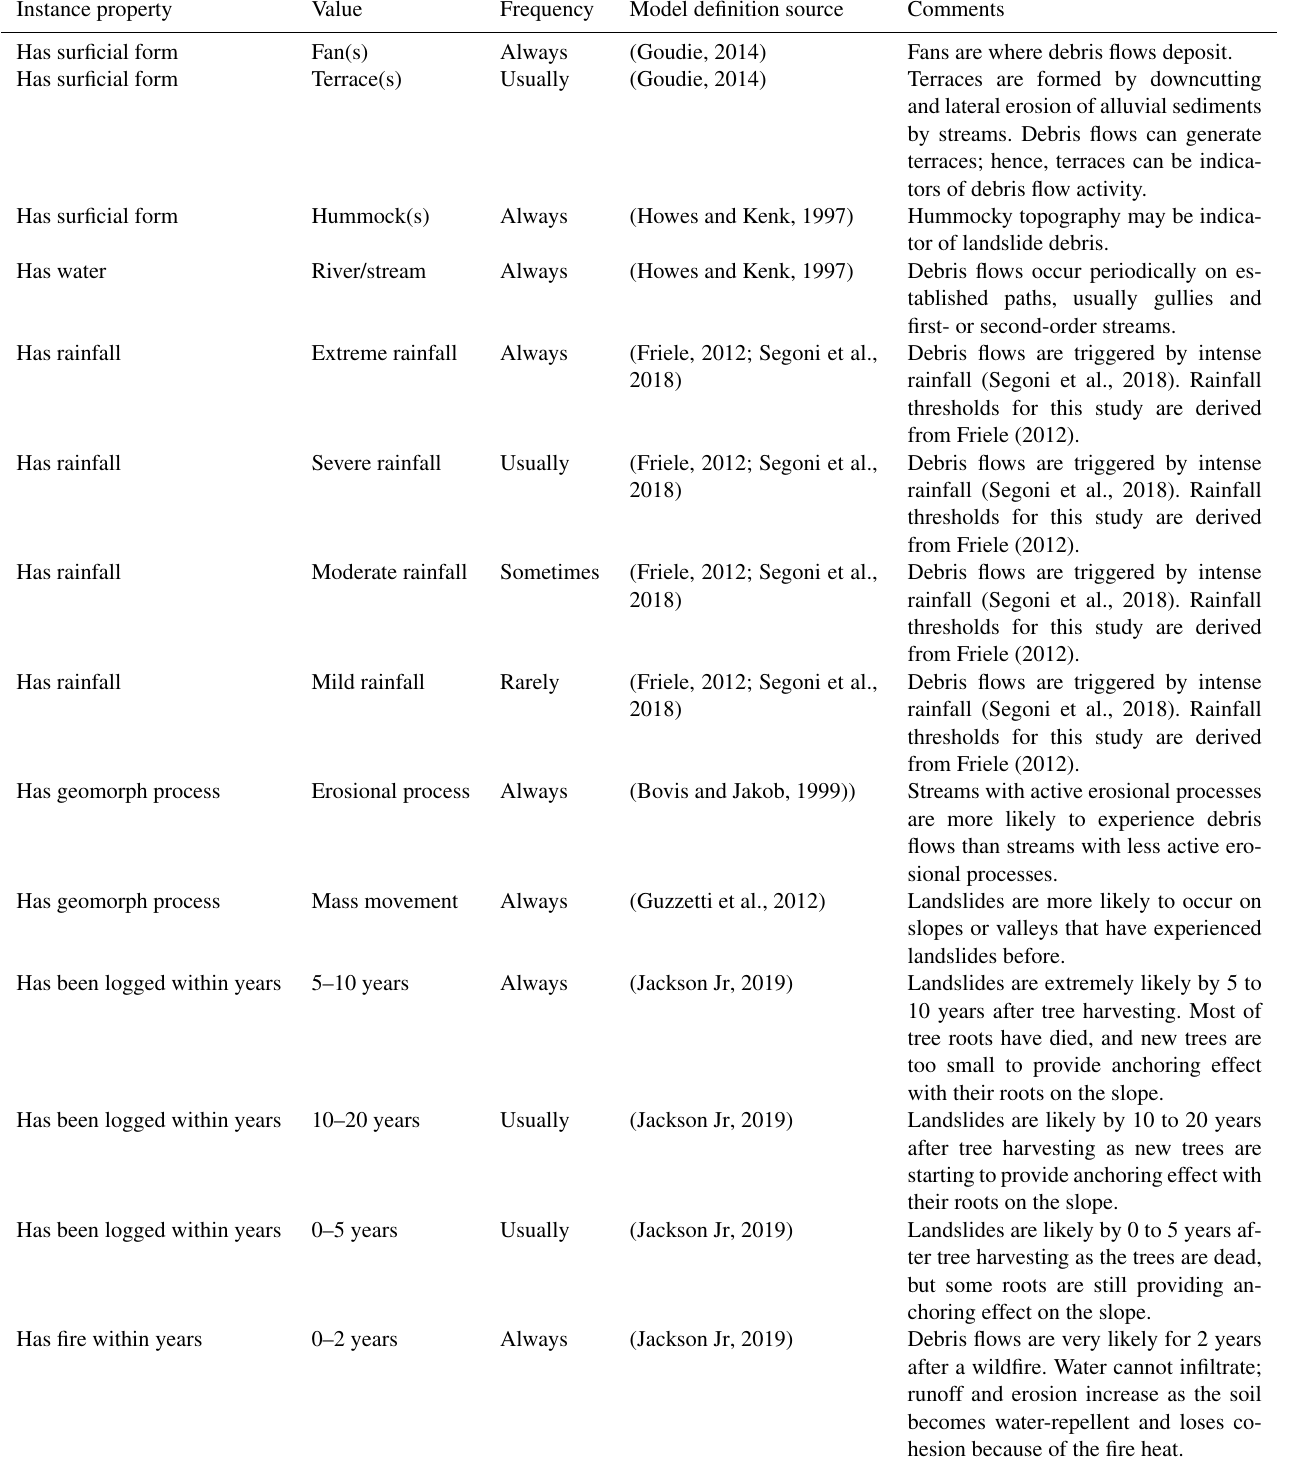
Table C1. Debris flow model (https://italy.minervageo.com/debris-flow-model/, last access: 26 October 2020)